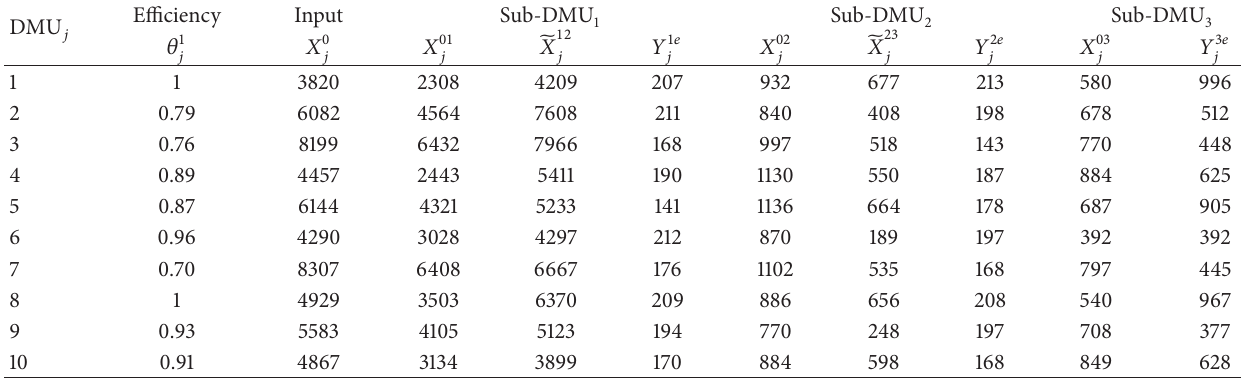
Table 2: Evaluation data of DN-DEA ( 𝑡 = 2 ).